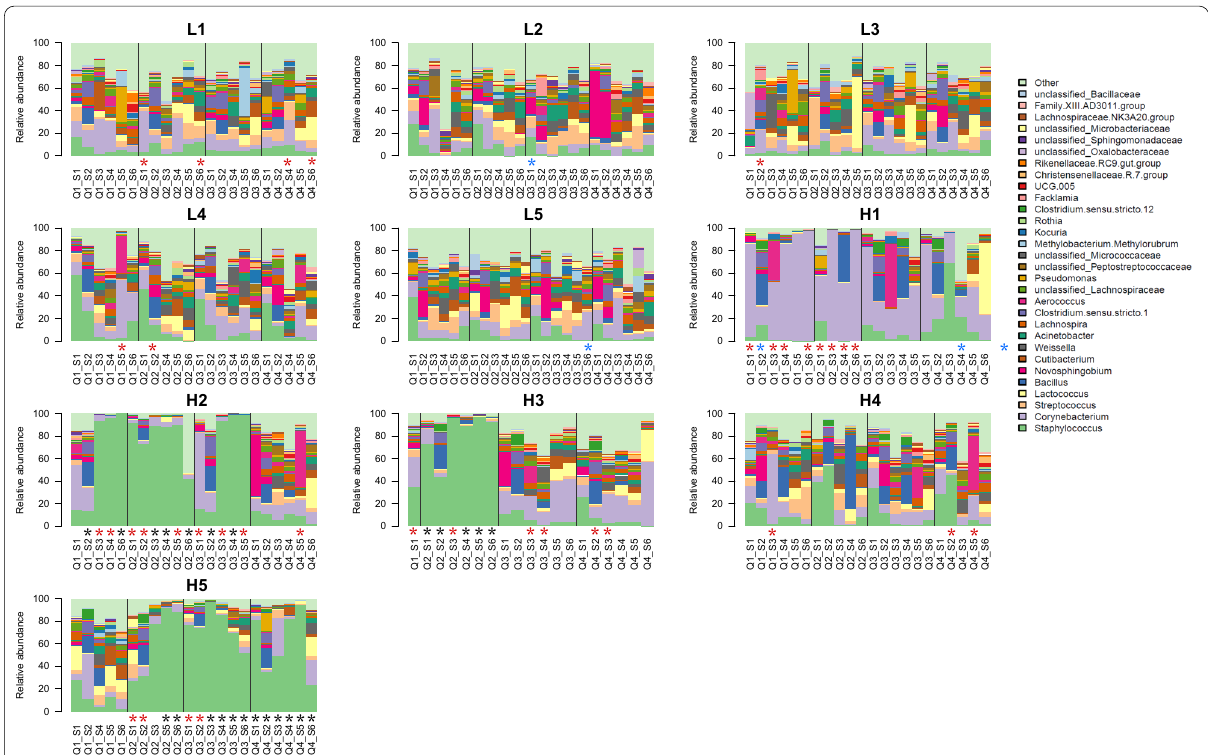
Fig. 4 The relative abundance of the 30 most abundant genera plotted for each quarter sample and displayed by cow ID over time. Each bar indicates a quarter sample, where Q1–4 represents the quarter (Q1: right back, Q2: left back, Q3: right front, Q4: left front) and S1–6 represents the sampling number. The asterisks indicate samples with recorded IMI (red, > 10 cultured colonies per 0.1 mL), SCC > 100,000/mL (blue) or both